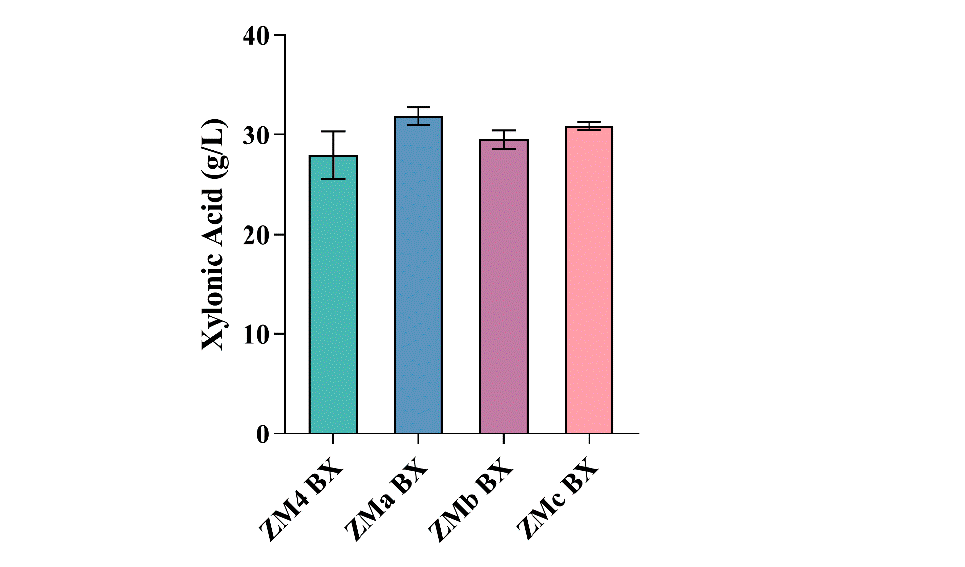
Figure 3. Xylonic acid production of engineered Z. mobilis strains expressing BX. Strains ZM4 (wild-type), ZMa (mutant for xylose reductase), ZMc (mutant for lactate dehydrogenase) and ZMc (double mutant) were transformed with plasmid pB1-XDH BX and grown for 24 h in shake flasks with modified RM 1 medium containing 50 g L − 1 xylose at 30 °C. Table 3. Production of xylonic acid, productivity and yield achieved by engineered strains of Z. mobilis expressing BX after 24 h of cultivation.